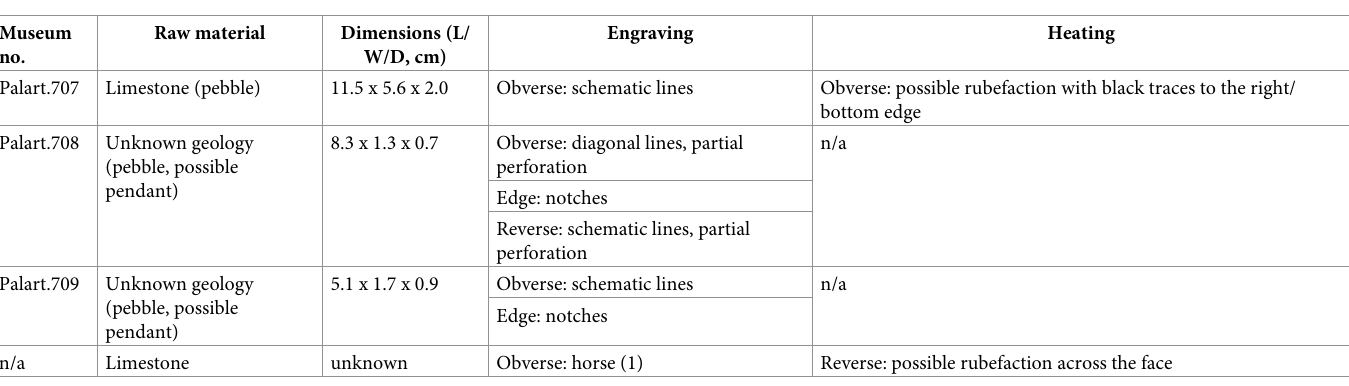
Table showing a summary of plaquettes from Montastruc detailing the material from which they are made, type and quantity of engraving, and modifications caused by heat. Note that ‘black traces’ could link to residue of burned fuel, or possibly taphonomic manganese dioxide staining, and should be treated with greater caution. Information derived from [21,